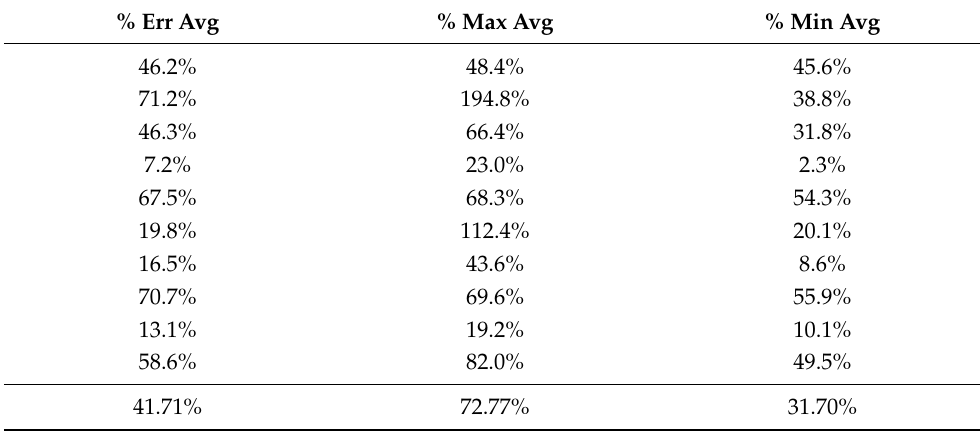
Table A72. Set 1, trials 41–50 data (actual PR value).